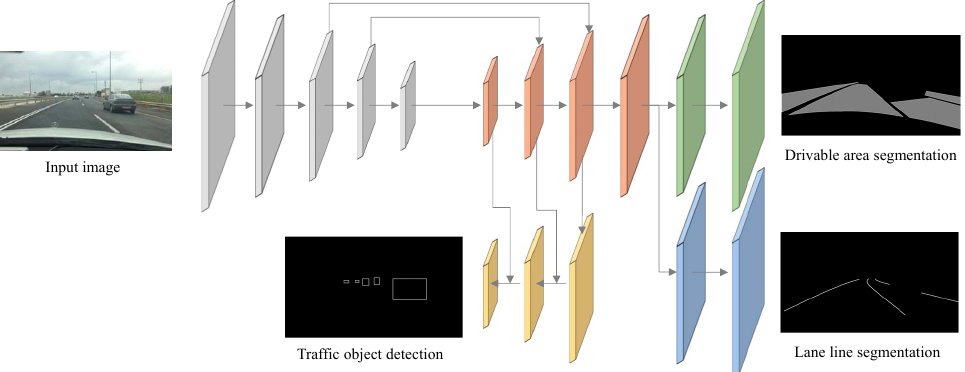
Figure 2. The overall architecture of the proposed network. The input image is fed into the encoder part, then the three decoders share the representations for different tasks at each